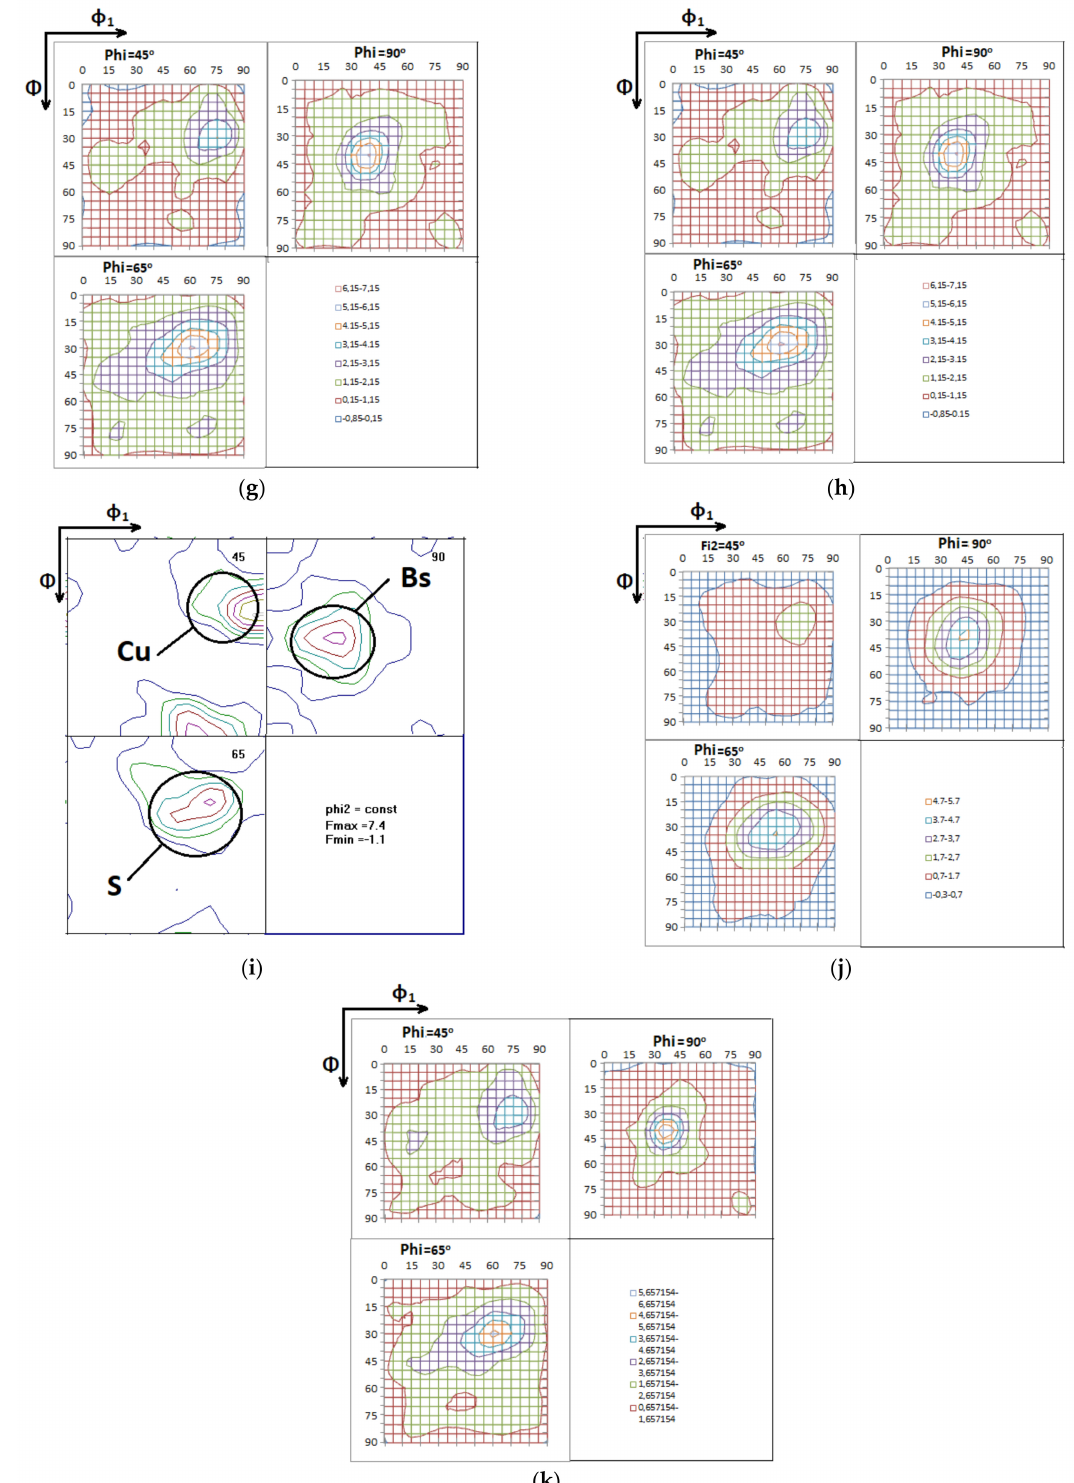
Figure 21. Calculation results for 1565 alloy: ( a ) homogenization, ( b ) 33.2% deformation, ( c ) 33.2% deformation (modeling), ( d ) 83.53% deformation, ( e ) 83.53% deformation (modeling); holding at 32.2% deformation and elevated temperature: ( f ) experimental data, ( g ) taking fragmentation into account, ( h ) without regard to fragmentation of intermetallic compounds; holding at 83.53% deformation and elevated temperature: ( i ) experimental data, ( j ) taking fragmentation into account, ( k ) without regard to fragmentation of intermetallic